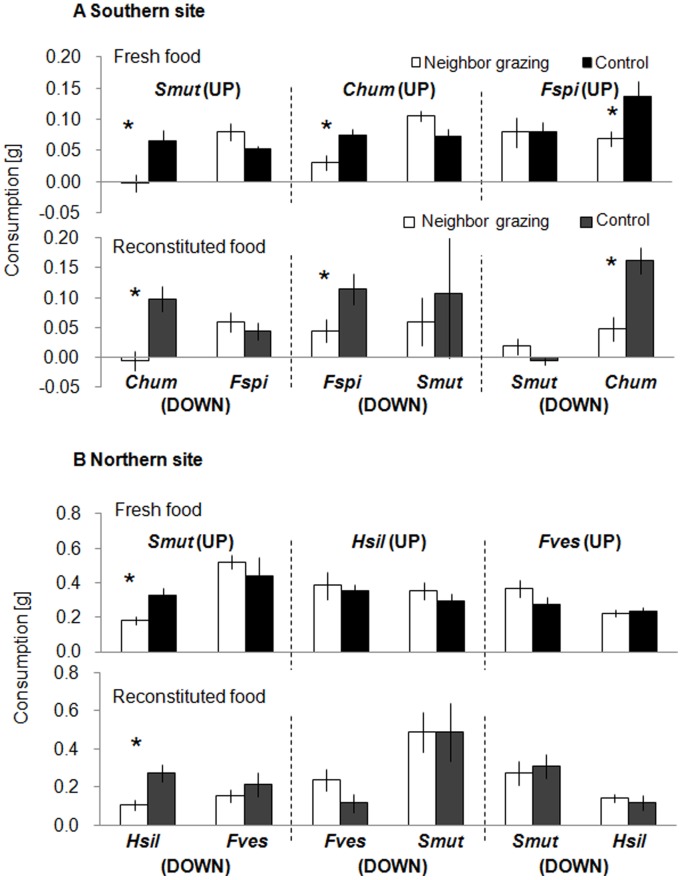
Effects of waterborne cues on heterospecific seaweeds.Mean consumption (±SE) of fresh and reconstituted seaweed pieces by the isopod Stenosoma nadejda from the southern site (A) and Idotea baltica from the northern site (B) in two-choice feeding assays. The seaweed pieces used in the assays were positioned downstream of grazed ( = cue-exposed) and ungrazed ( = control) hetero-specifics in the induction phase. ‘Up’ and ‘down’ indicate the position of the seaweed species in aquaria during the induction phase. Note different scaling of ordinate between southern and northern sites (n = 8). Interpretation of symbols, abbreviations, and explanation of negative values in assays using reconstituted food as in Fig. 1.